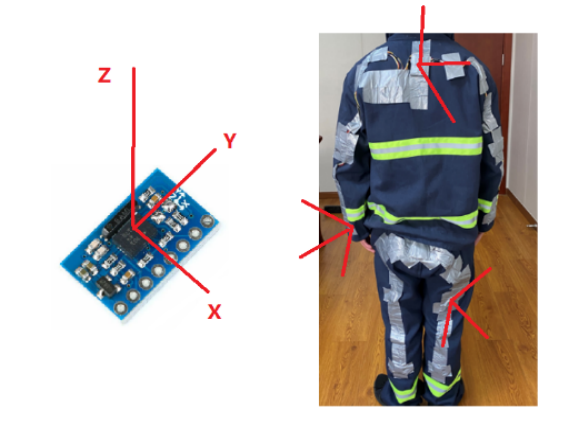
Figure 10. Local IMU coordinate system on PJ and